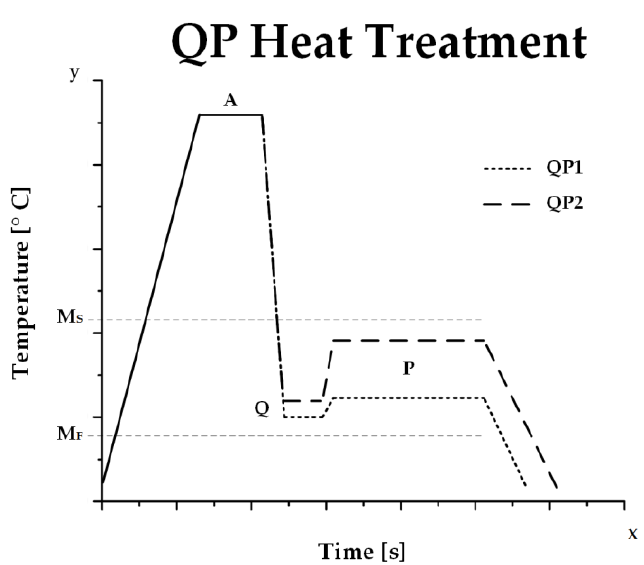
Figure 1. Scheme of the QP heat treatment for the investigated QP1 and QP2